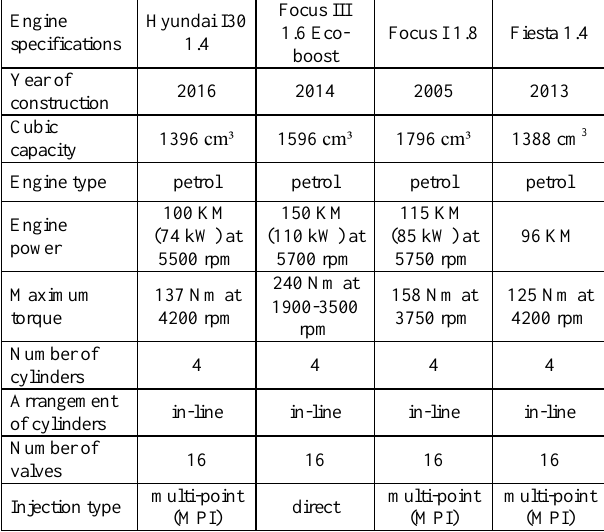
Table 1. Basic technical parameters of internal combustion engines tested Engine